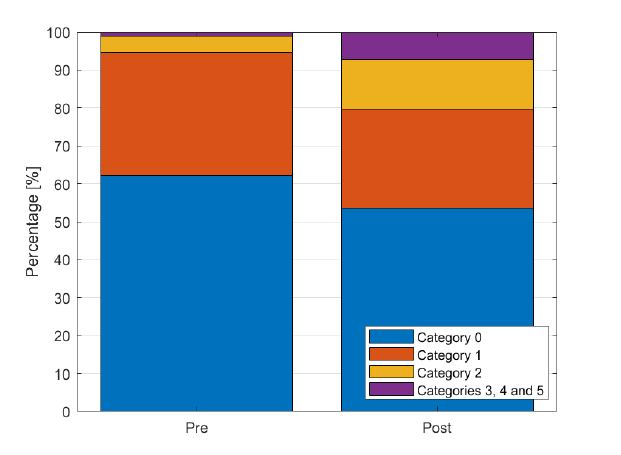
Figure 9. Bar graph with the percentage of whistles grouped by morphological categories in pre- and post-scenarios.